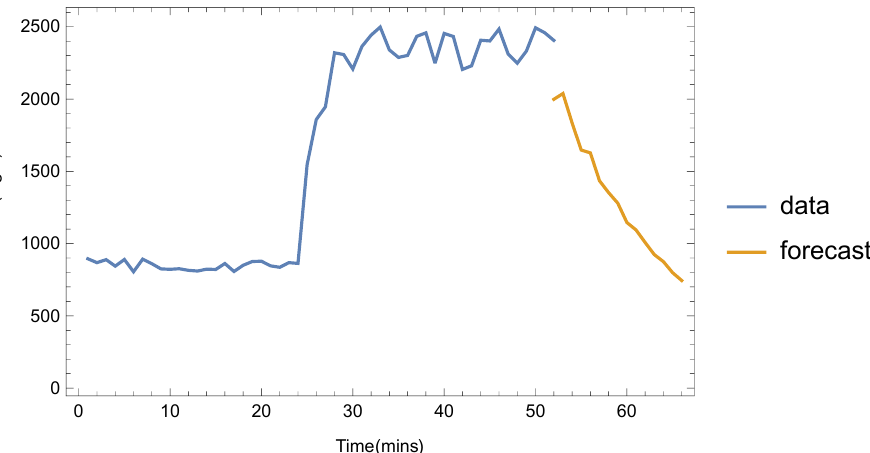
Figure 7. Forecasting the T0C 1 values using a single-variable method (data points are separated by 1 min intervals).